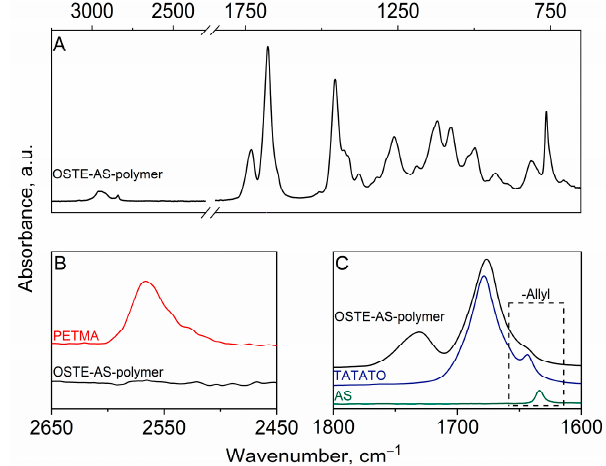
Figure 3. The FT-IR spectra of the OSTE-AS polymer: ( A ) full spectrum; ( B ) the region of thiol group bands; ( C ) the region of allyl group bands. Full spectra of TATATO, PETMA, AS, and prepolymer are presented in Supplementary Materials Figure S2.